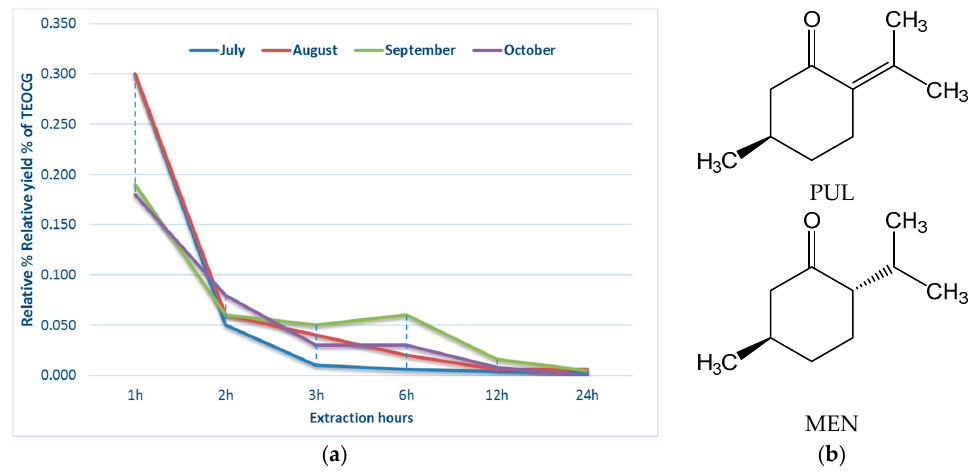
Figure 2. ( a ) Yield curves for CG; ( b ) chemical structures of pulegone (PUL) and menthone (MEN).